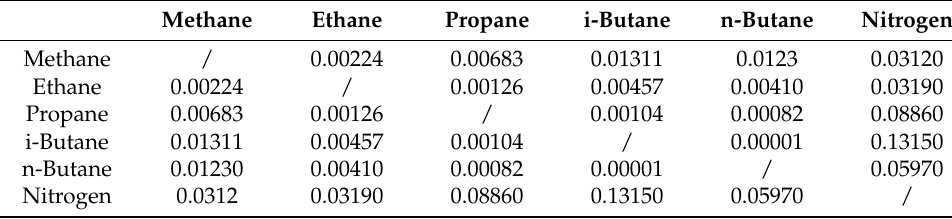
Table 5. Binary interaction parameters of the SRK equation of state.